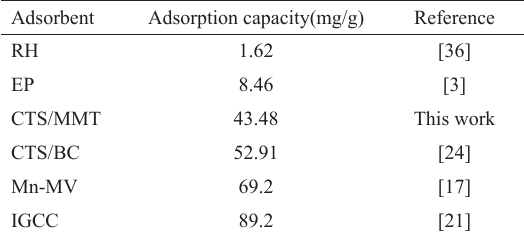
Table 3: Comparison among adsorption of different adsorbents for Ag + . Adsorbent